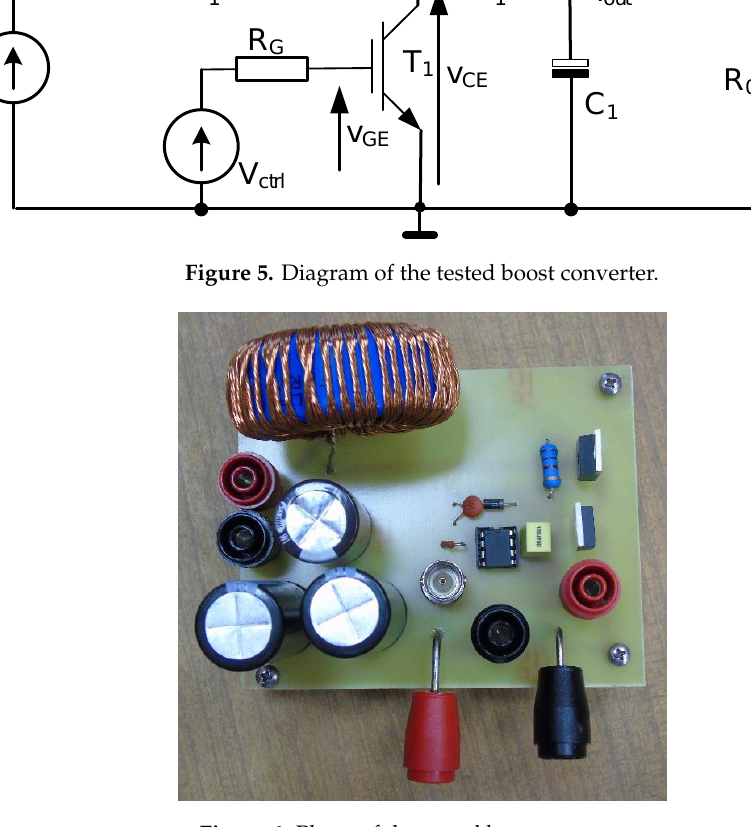
Figure 6. Photo of the tested boost converter.